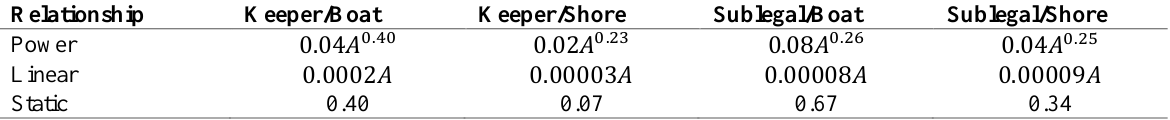
Table A1.2. The power, linear, and static abundance-catch relationships used to represent the likelihood of catching a keeper or sublegal fish from shore or boat fishing methods, where A represents abundance. Value sources for these equations can be found in the main text (see “Submodels”